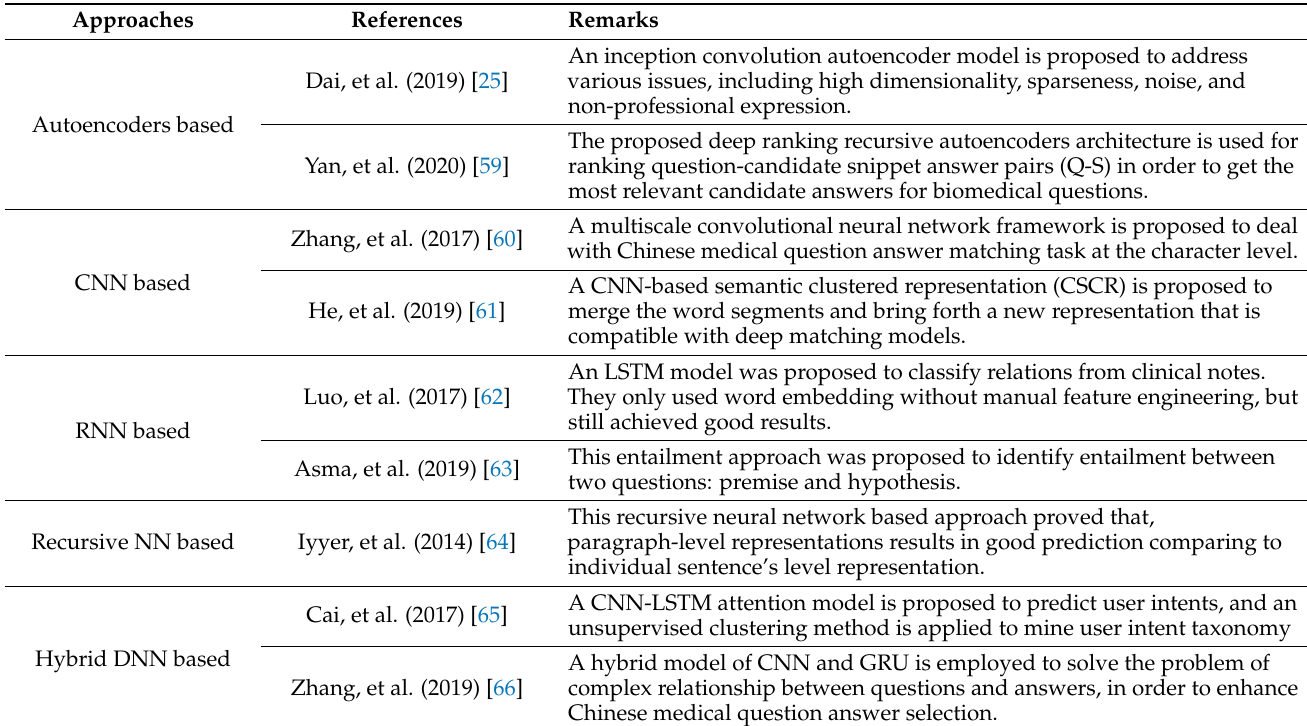
Table 2. classification of papers based on approaches